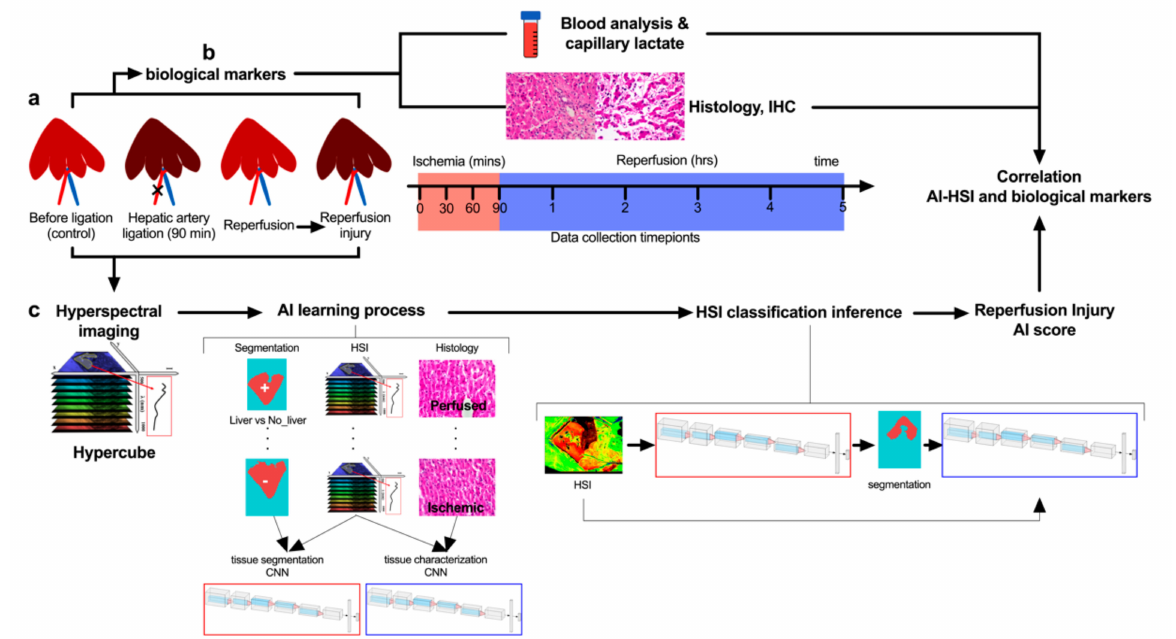
Figure 1. Experimental workflow. ( a ) Hepatic artery occlusion (HAO) was performed for 90 min followed by a reperfusion phase of 5 h. ( b ) During ischemia and reperfusion time, biological data and hyperspectral imaging (HSI) were sampled. ( c ) Hyperspectral imaging was acquired providing the hypercube with a wavelength range from 500 to 1000 nm. Two artificial intelligence-based convolutional neural networks (CNNs) were trained to perform a segmentation that could identify the liver surface and analyze the same surface to predict perfused and not perfused livers during the ischemia phase. Finally, the tissue classification produced by the CNNs was used to create a score of liver viability during the reperfusion phase. While StO 2 % and NIR% are calculated with the preset algorithm of the HSI (TIVITA software), the AI score is calculated over the whole spectra using the